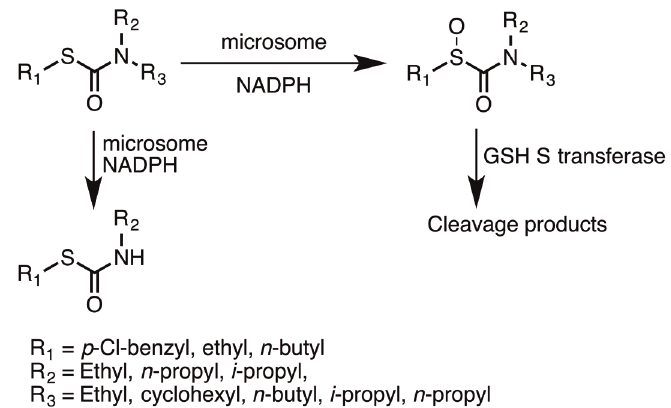
Figure 30 - Oxidation of thiocarbamate herbicides by liver enzymes.